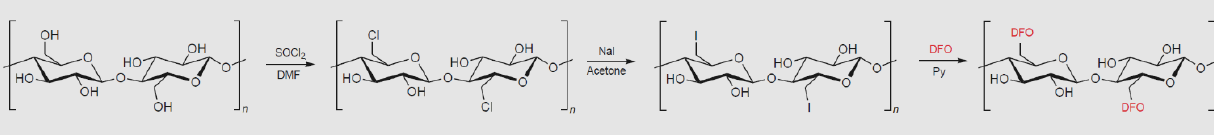
Figure 3. Synthesis scheme for the DFO-paper preparation. (Adapted with permission from [5], Copyright 2017 Springer Nature)